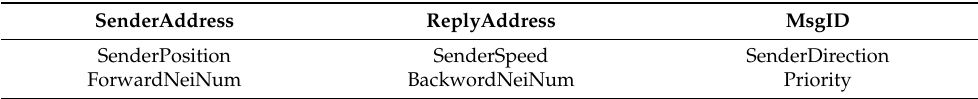
Table 1. The structure of the beacon message.